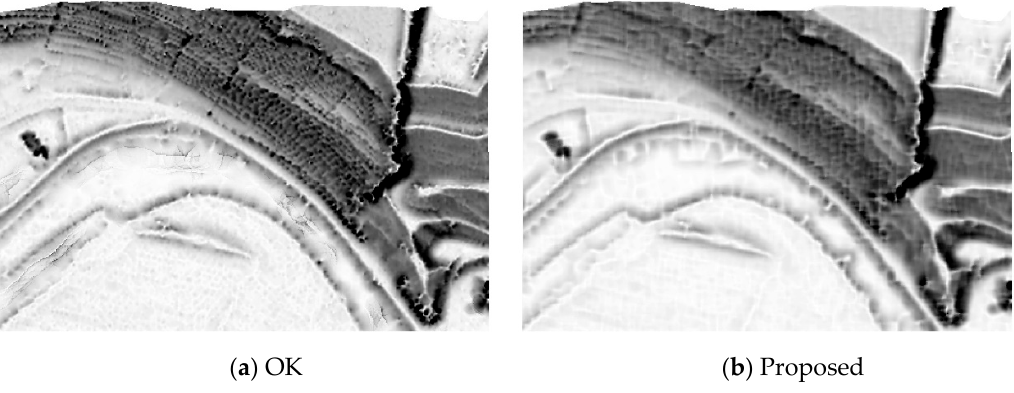
Figure 8. Sky-view factors of ( a ) OK and ( b ) the proposed method on s-52.